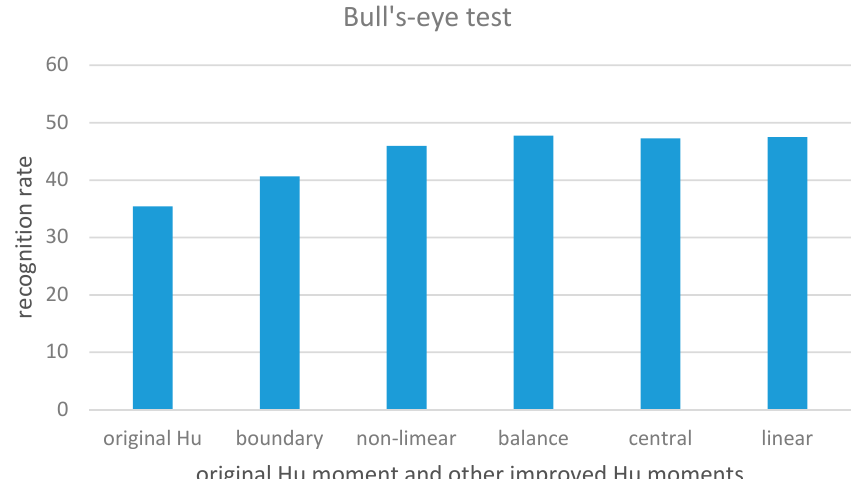
Figure 5. Bull’s-eye test on MPEG-7 shape database.